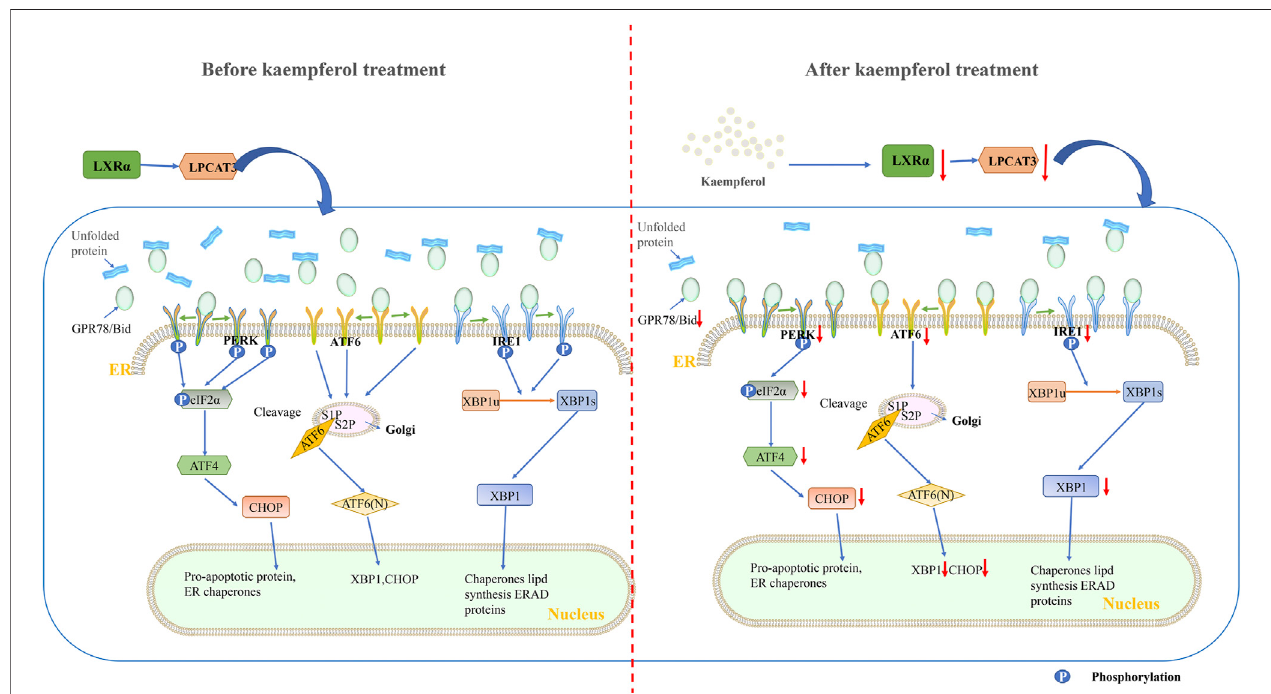
FIGURE 8 | Schematic diagram of the mechanism of KP regulating LXR α -LPCAT3 signaling pathway. KP intervention suppressed endoplasmic reticulum stress. The LXR-LPCAT3-ERS pathway is activated when induced by HFD or PA/OA. This allows unfolded proteins to accumulate in the ER. At the same time, GPR78 dissociates from PERK, IRE1, and ATF6, and then binds to the unfolded protein. The dissociated PERK, IRE1 and ATF6 were activated. CHOP-induced apoptosis occurs when PERK, IRE1, ATF6 and their downstream pathways are continuously activated. The expression of LXR and LPCAT3 decreased signi fi cantly when treatedwithKP,andthentheunfoldedproteindecreased,PERK,IRE1andATF6dissociatedfromGRP78decreased.Abbreviations:HFD:highfatdiet,PA/OA:Palmitic acid/Oleic acid, LPCAT3: lysophosphatidylcholine acyltransferase 3, LXR α : liver X receptor alpha, PERK: protein kinase R-like ER kinase, Eif-2 α : eukaryotic translation initiation factor 2 α , ATF6: activating transcription factor 6, IRE1: inositol-requiring enzyme 1, XBP1: X-box-binding protein 1, ATF4: activating transcription factor 4, CHOP: C/EBP homologous protein, ERAD: Endoplasmic reticulum-associated